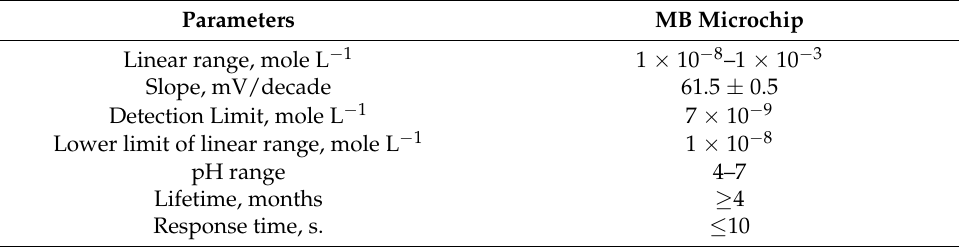
Table 1. Potentiometric response parameters of the MIP-based MB microchip.